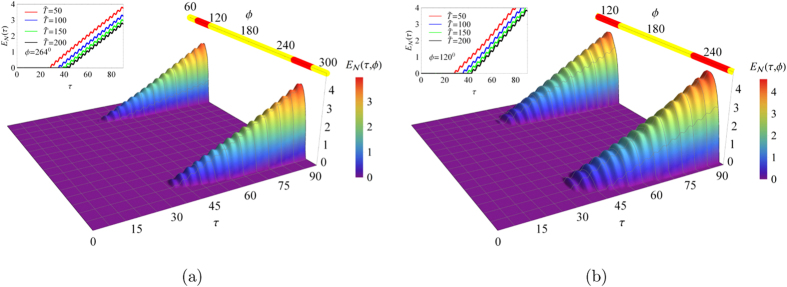
Surfaces of logarithmic negativity EN(τ, ϕ) and curves of EN(τ).In (a) ωd/ω0 = 2ωr, m = 4; in the inset ϕ = 264°. In (b) ωd/ω0 = 1.77ωr, m = 4; in the inset ϕ = 120°. In both insets the used values are: γ = 0.01ω0, c = 0.09, ,  and  and 200.